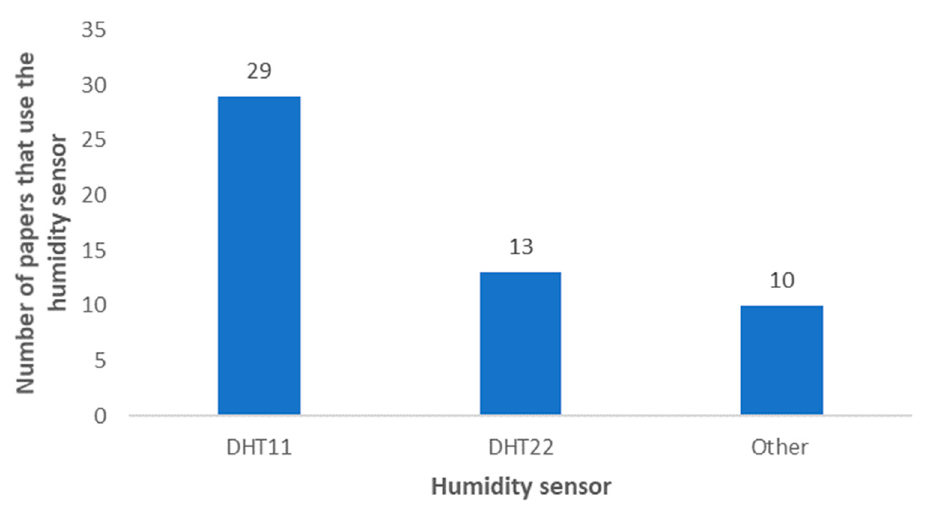
Figure 17. Most utilized humidity sensors. Table 3. Relative humidity monitoring sensors.